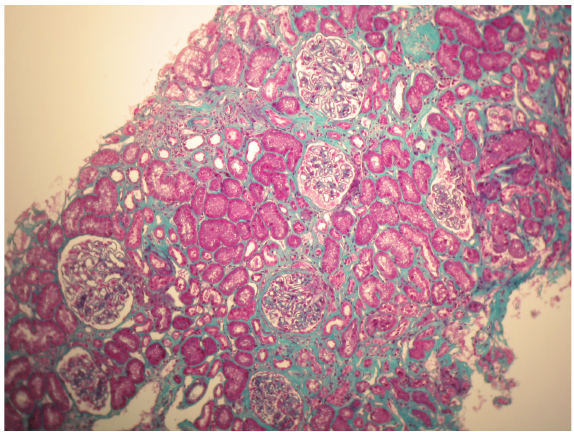
Figure 2: Glomeruli with thickened basement membrane (Mas- son’s trichrome,